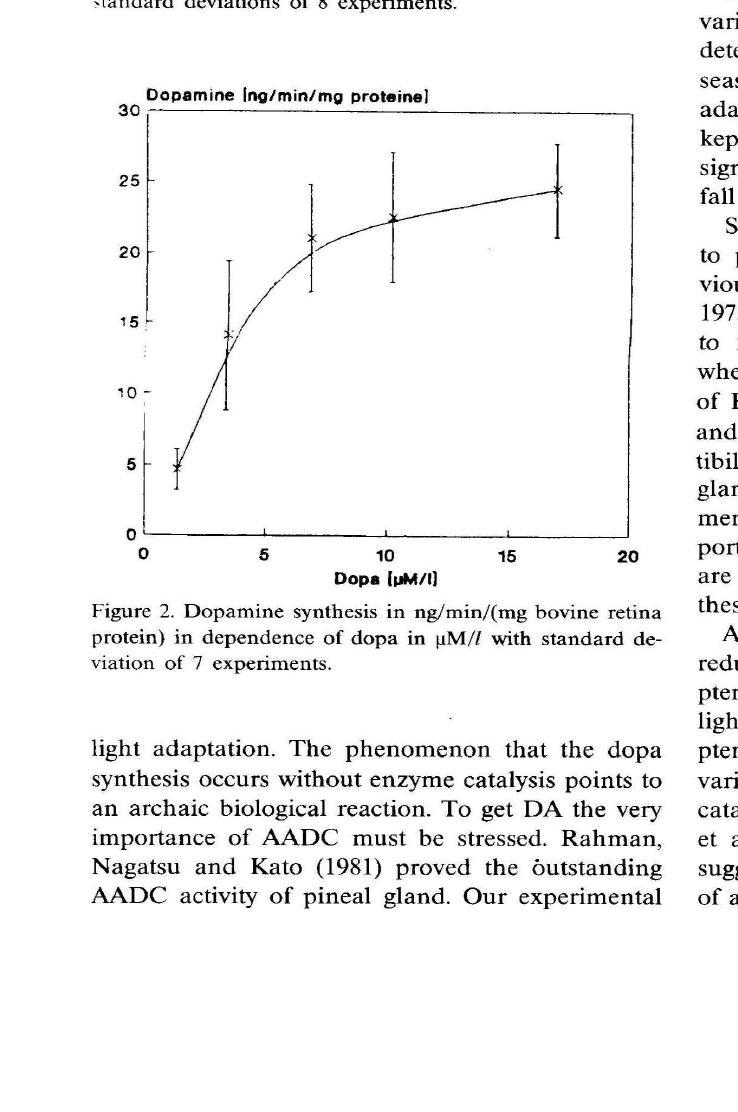
Figure 1. Synthesis of dopa in JlM/1 in dependence of tet ~ahydromonapterin (MH4) (line and crosses) and tetrahy ~robiopterin (BH4) (dasheded line and squares) in JlM/Z with -randard deviations of 8 experiments.